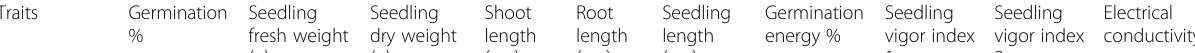
Table 4 Correlation coefficients among M 2 lentil seedling traits under 0.1% ethyl methane sulfonate (EMS)